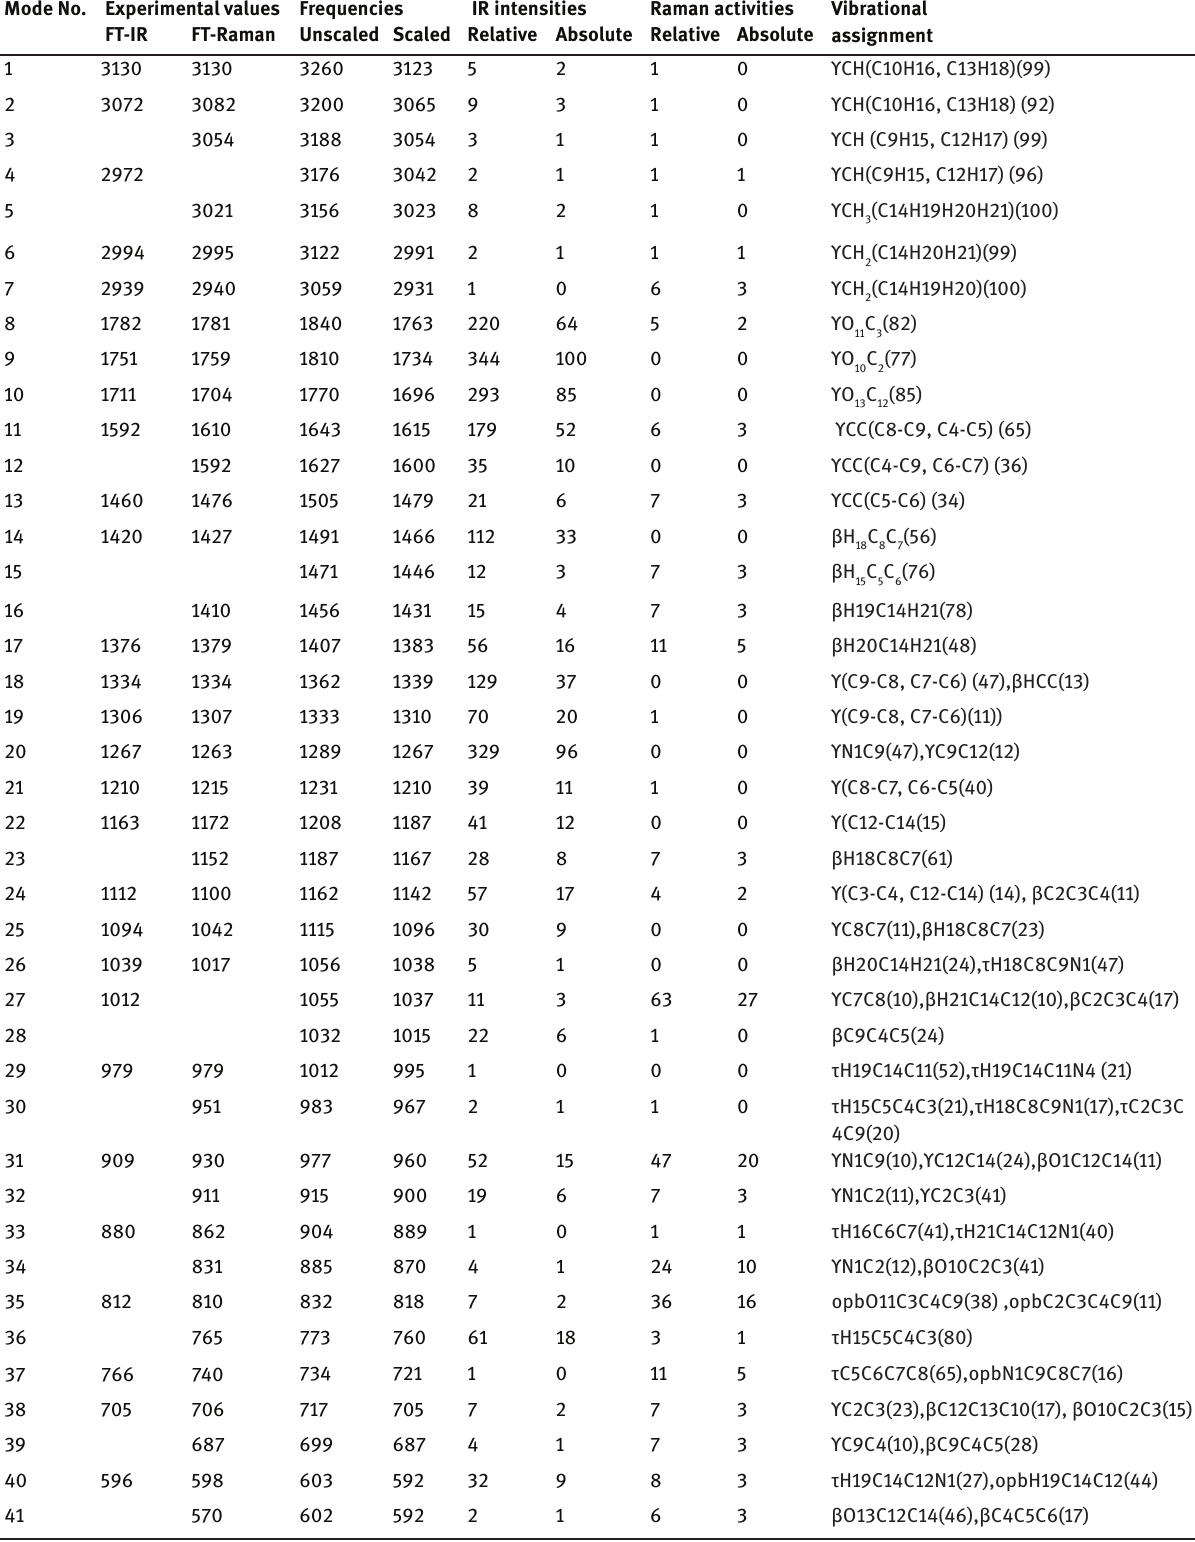
Table 2 : Vibrational assignment of fundamental modes of N -acetylisatin along with calculated FT-IR, FT-Raman intensities and normal mode descriptions (characterized by PED) based on quantum mechanical force field calculations using the B3LYP6-311++G(d,p) method. Mode No. Experimental values